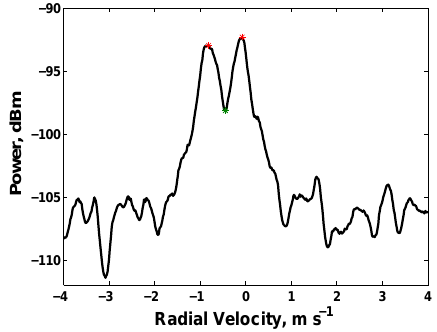
Figure 14. HCR spectrum collected in a mixed-phase cloud. The radar was ground-based and pointed